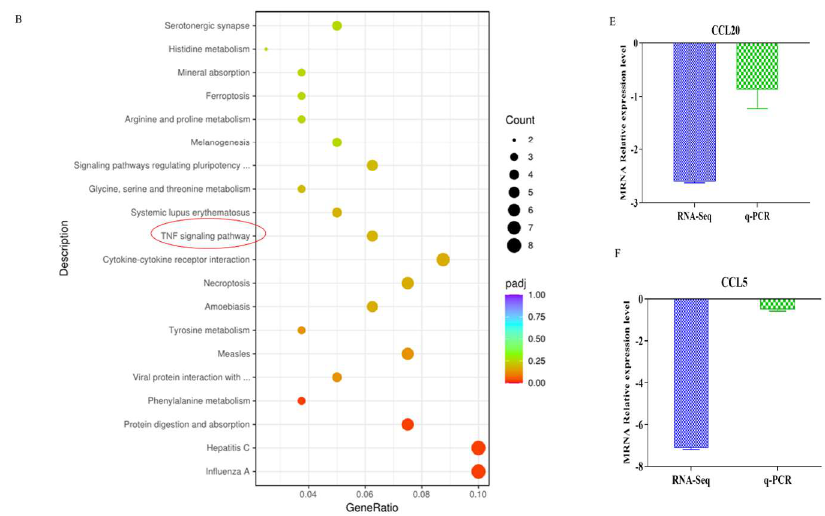
Figure 5. Enrichment analysis. ( A ) GO enrichment analysis histogram. The abscissa was GO term, the ordinate was the significance level of GO term enrichment, represented by −log 10 ( p -value, and different colors indicate different functional classifications. ( B ) KEGG enrichment scatter plot. The abscissa coordinate is the ratio of the number of differential genes to the total number of differential genes annotated to the KEGG pathway, and the ordinate is the KEGG pathway, red circles indicate the selected pathway ( C – F ) Validation of representative by q-PCR (n = 5) Log 2 p -value. TNFAIP3: tumor necrosis factor induced protein 3, CCL5 : chemokine ligand 5, CCL20 : chemokine ligand 20, SELE : selectin endothelial an adhesion molecule.